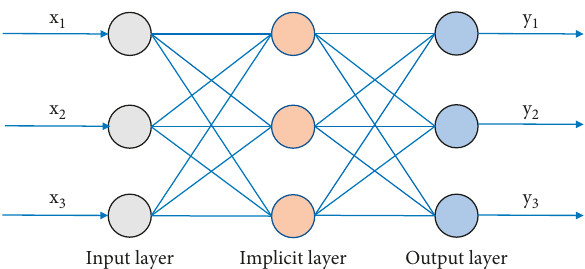
Figure 7: Structure of a three-layer neural